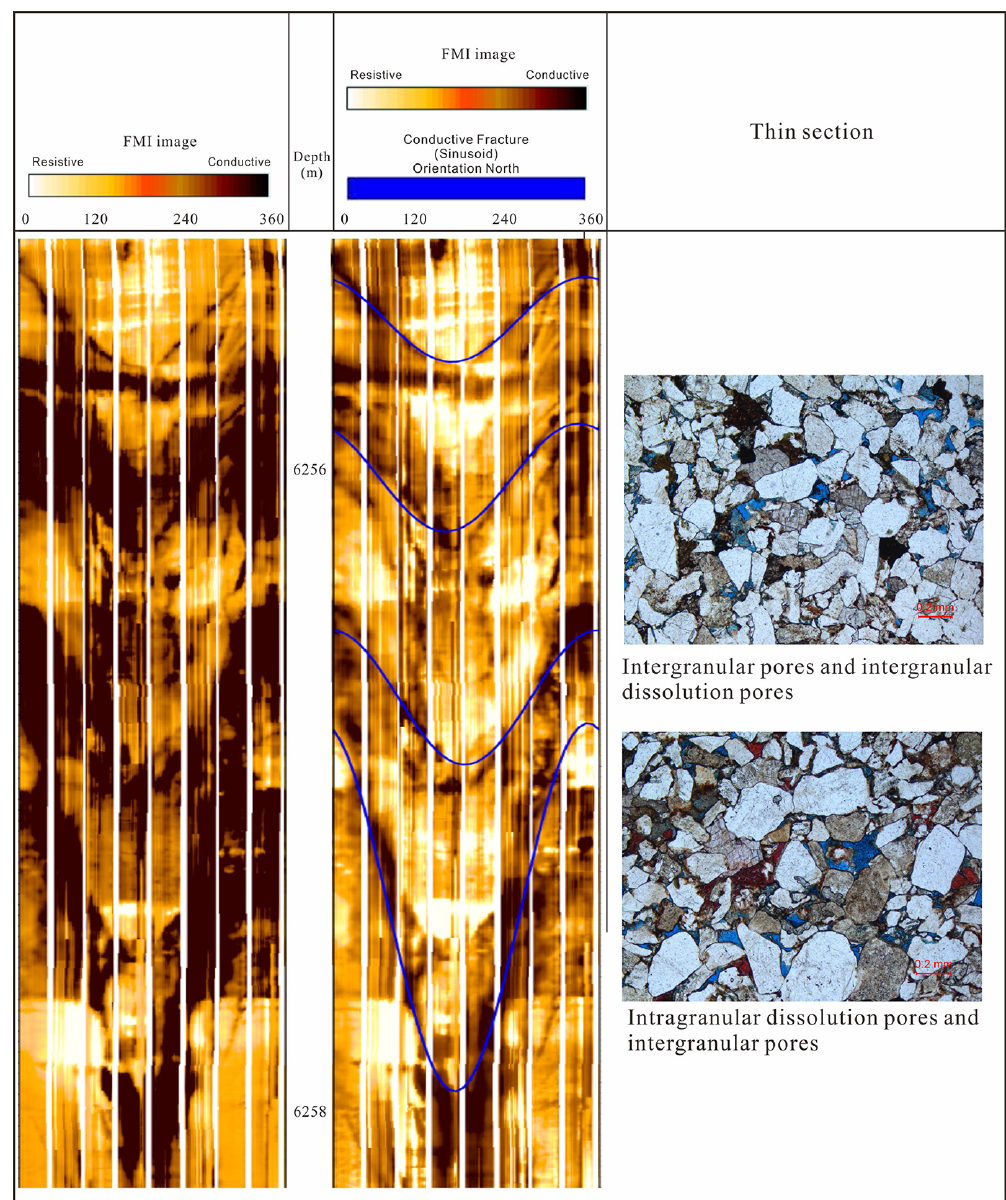
Figure 18. Presence of fracture enhance dissolution and dissolution pores is mainly associated with fractures (Bozi 21).